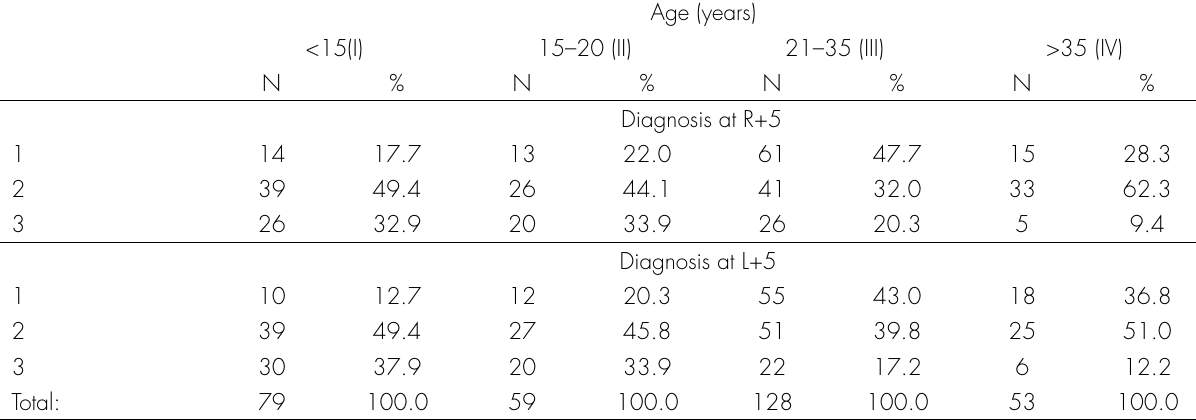
patients’ age was identified. Table III. Transverse palatal suture morphology assessed at R+5 and L+5 topographic points in various age